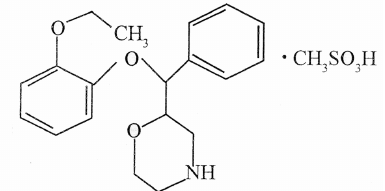
Figure 1. Reboxetine methane sulphonate